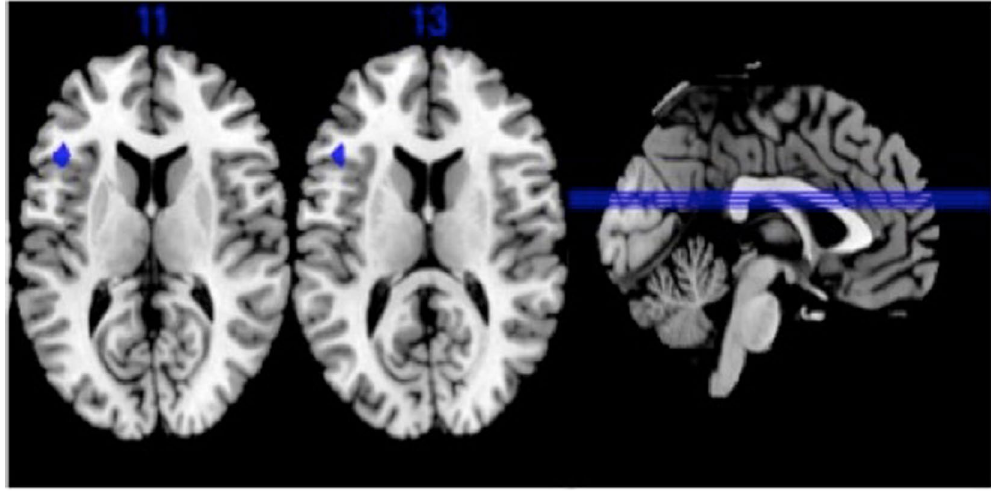
Figure 1. Main effect of conditions in healthy controls (voxel p-FWE corrected < 0.05, k ≥ 10) Brodmann Areas